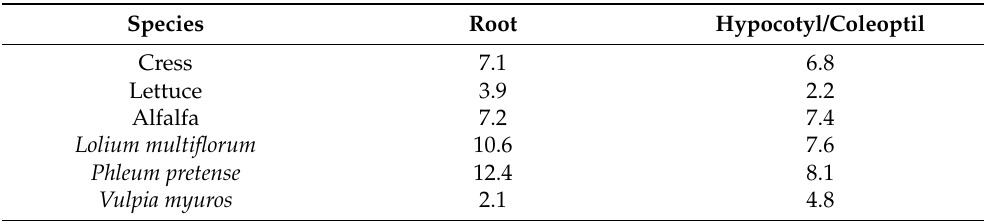
Table 1. IC 50 values (mg dry weight equivalent extract per mL) of the extracts of M. glyptostroboides fallen leaves on the growth of roots and hypocotyls/coleoptiles of bioassay plant species. The values were determined by the regression equation of the concentration–response as described in the text.